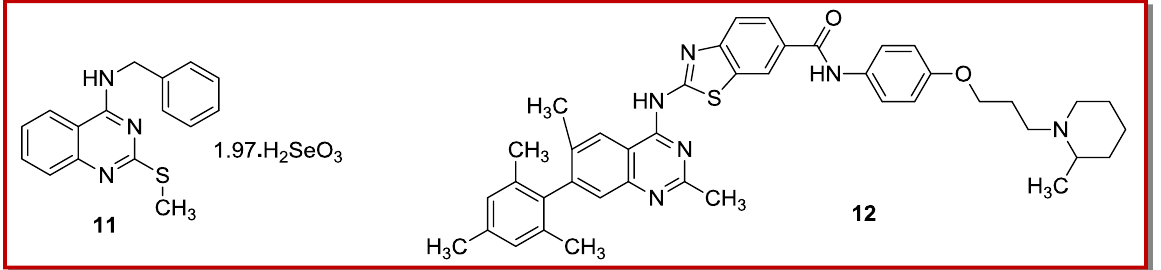
Figure 7: Some quinazoline motifs with antitumor